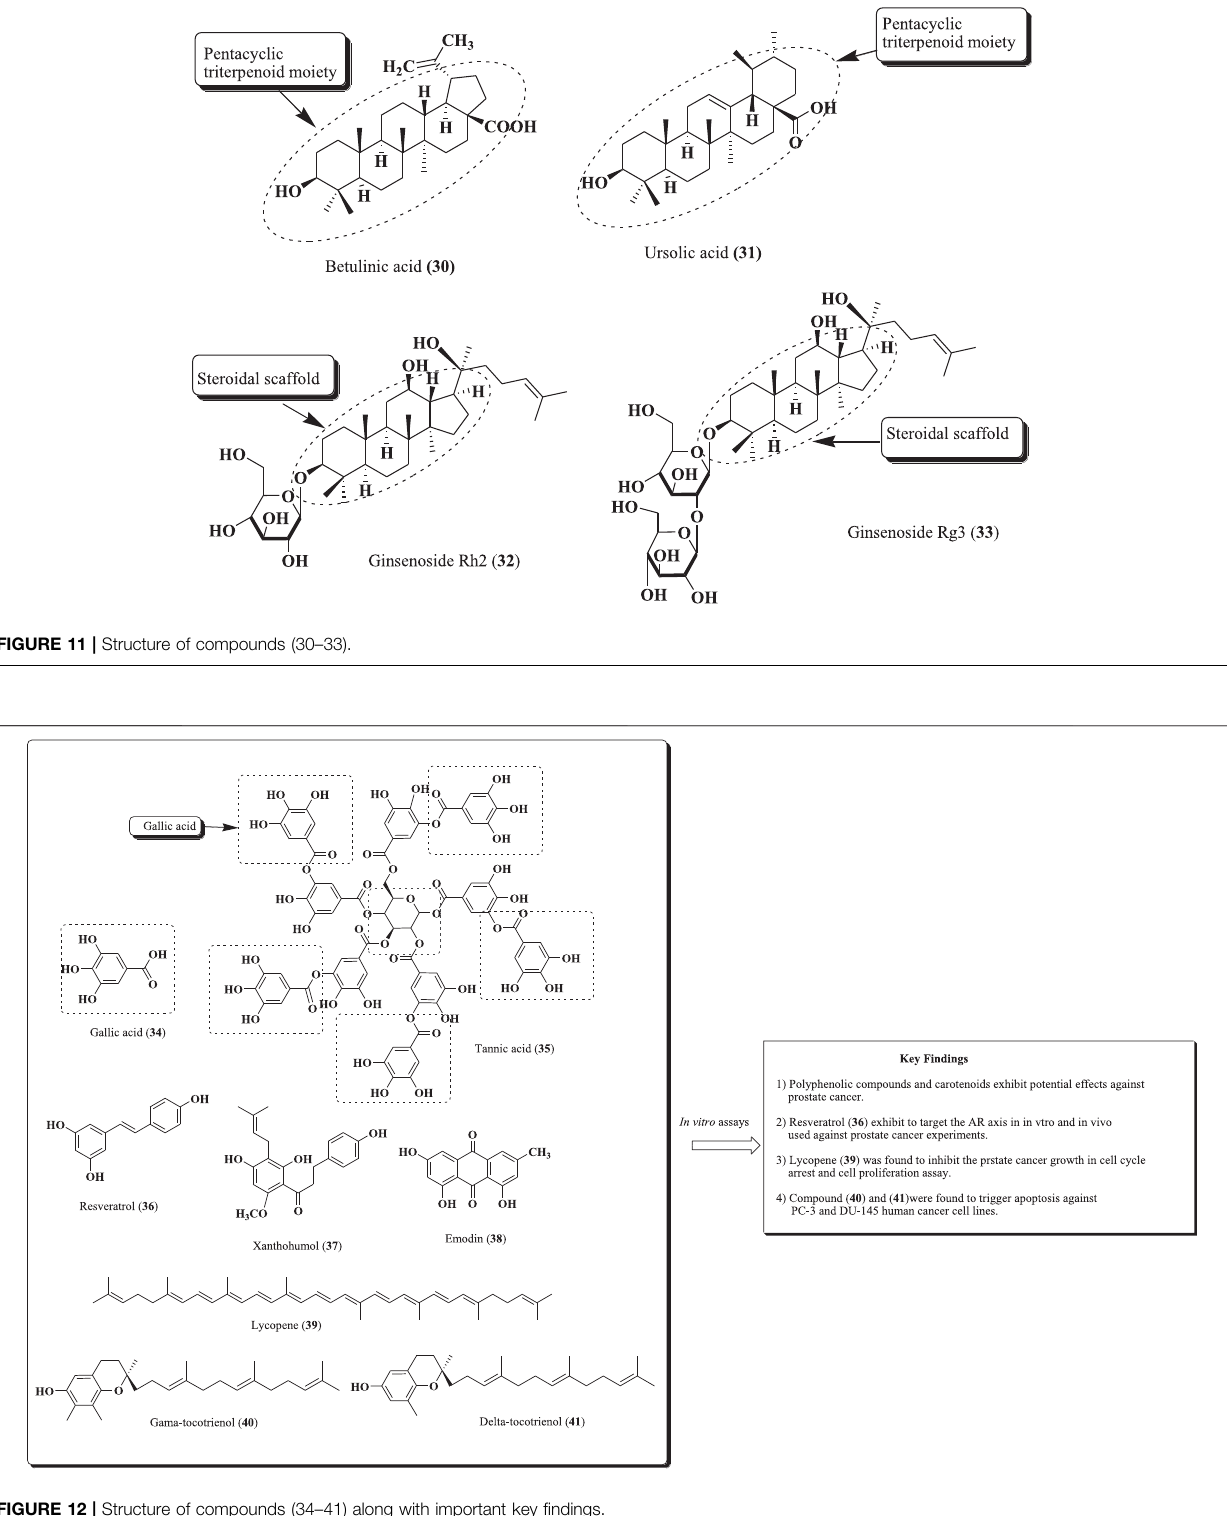
Frontiers in Pharmacology |